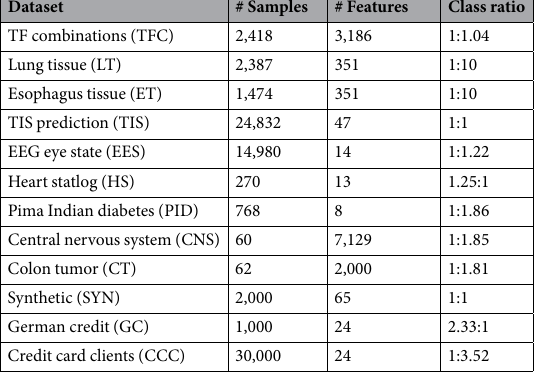
Table 1. Datasets